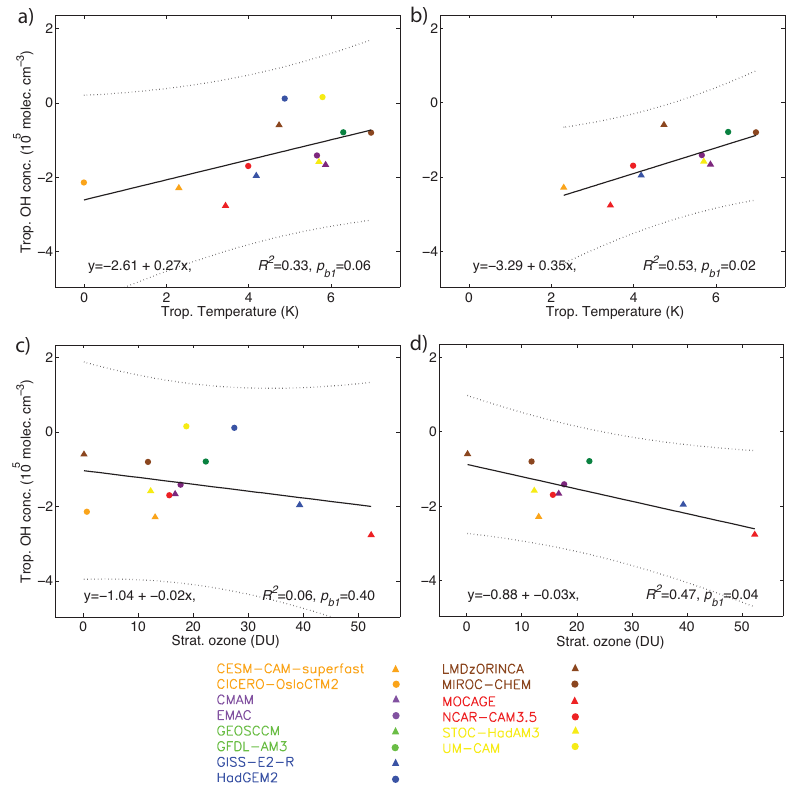
Fig. 10. Linear relationship between 2000–2100 changes in global mean tropospheric OH and 2000–2100 changes in (a) global mean temperature, and (c) global mean stratospheric ozone column, across all models. The same relationship is shown after excluding the two models that did not have interactive photolysis, namely HadGEM2 and UM-CAM, and the model that did not take into account meteorology changes between 2000 and 2100, namely CICERO-OsloCTM2 (b, d) . Dashed lines show the prediction intervals at a 95% confidence level.